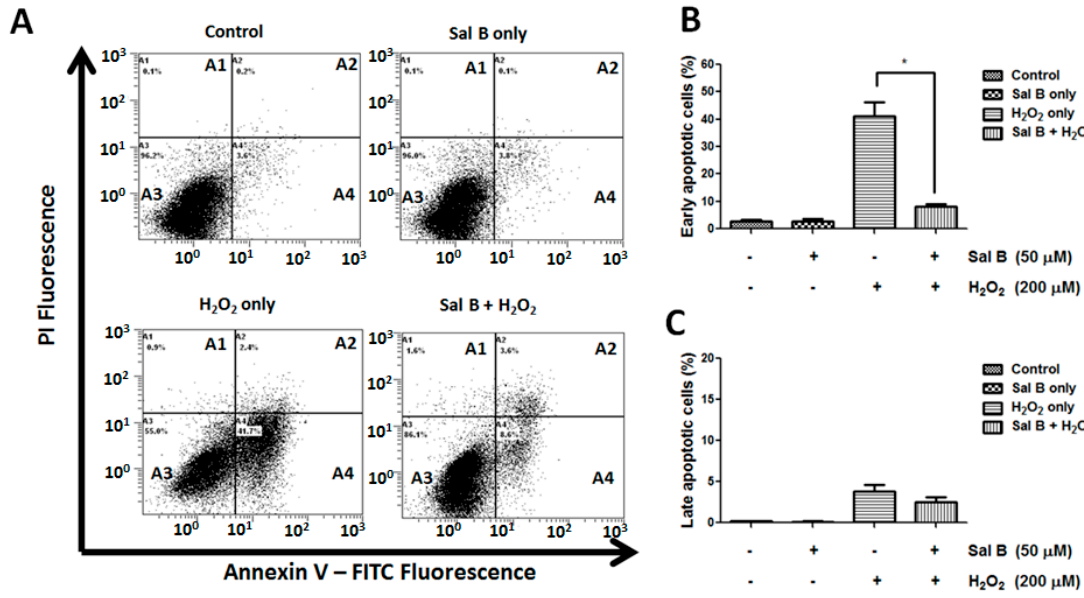
Figure 2. Sal B decreases apoptotic cell death in H 2 O 2 -treated RPE cells. ( A ) Flow cytometry